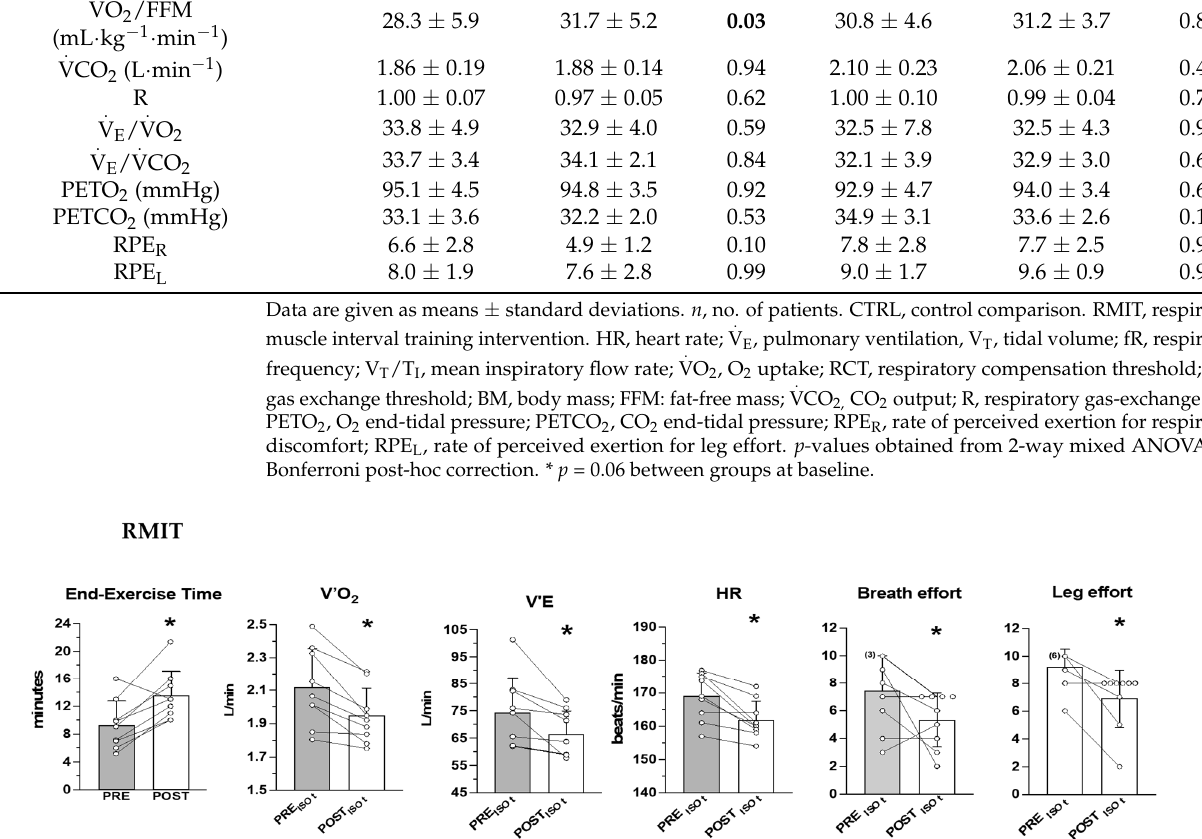
Figure 1. RMIT. Mean ( ± SD) and individual values of time to exhaustion, and ISO-time perceived effort for breathing (RPE R ) and leg movements (RPE L ) determined during constant work rate cycling at 130% of the work rate at GET, before (PRE) and after (POST) the RMIT program. ISO- time corresponds to the individual time to exhaustion before the intervention, or after the intervention for the participant who reduced the duration of the exercise. The number of overlapped data is reported in parenthesis next to the symbol. * significant difference vs. PRE (Time to exhaustion, . . p = 0.0003; VO 2, p = 0.0007; V E , p = 0.01; HR, p = 0.02; RPE R , p = 0.03; RPE L , p =